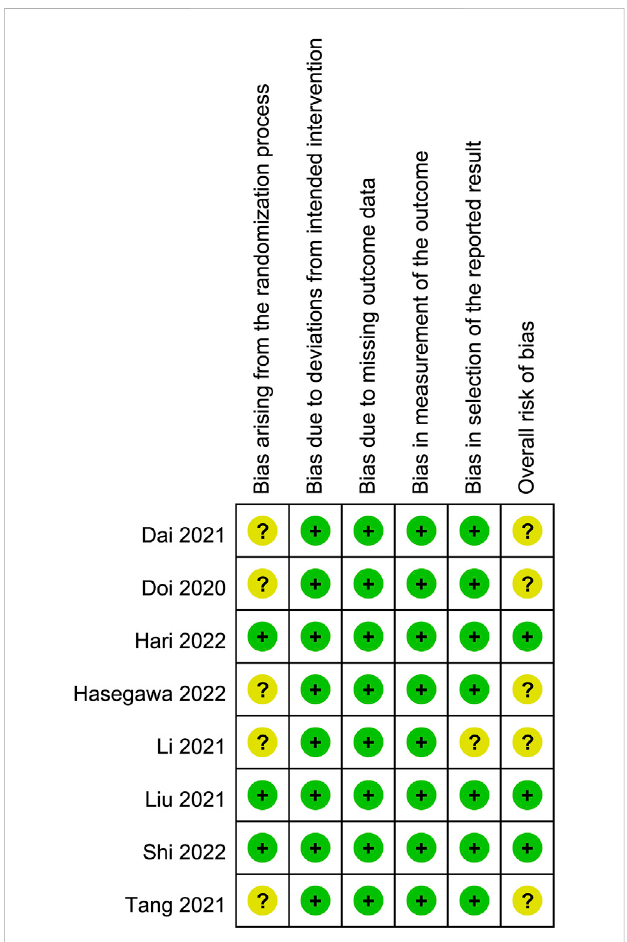
FIGURE 2 Risks of bias of the included studies. Risk of bias. Green: low risk; yellow: some concern; red: high